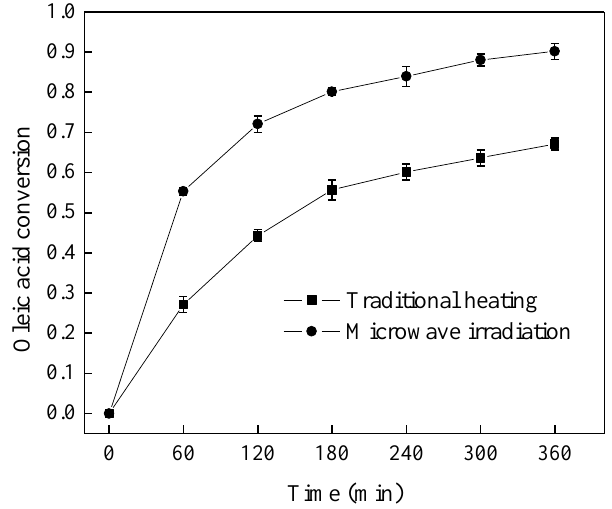
Figure 1. Comparison of esterification using conventional heating and microwave irradiation. Reaction conditions occurred with an ethanol:oleic acid molar ratio of 2:1, temperature of 433 K, and microwave power of 150 W (for microwave irradiation). Vertical bars illustrate the standard deviation of three replicates.